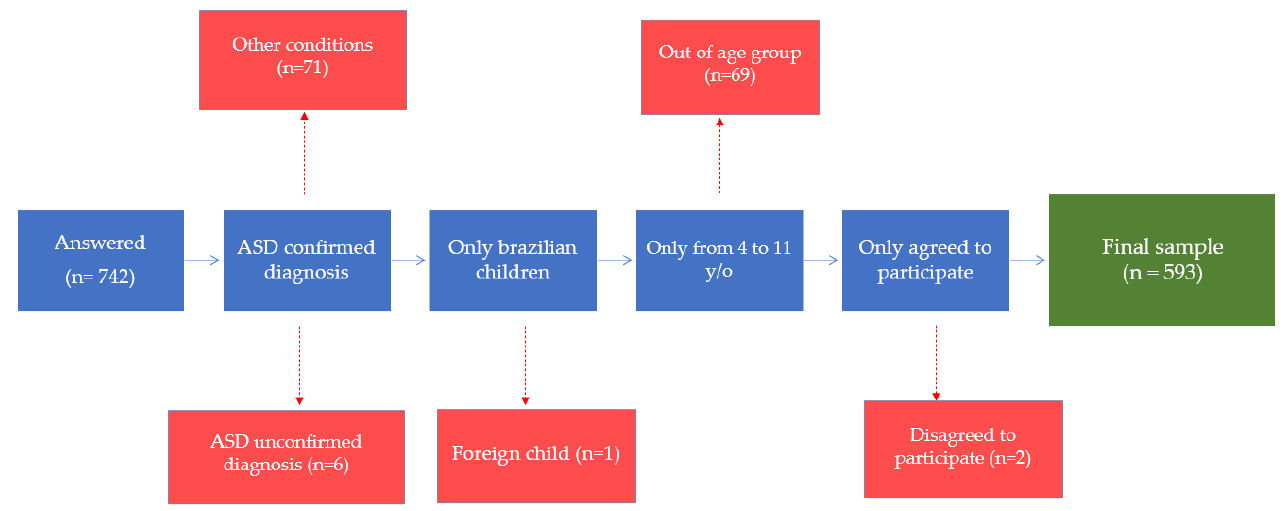
Figure 1. Schematic representation of the study sample (Brazil, 2020 – 2021). ASD: autistic spectrum disorder.